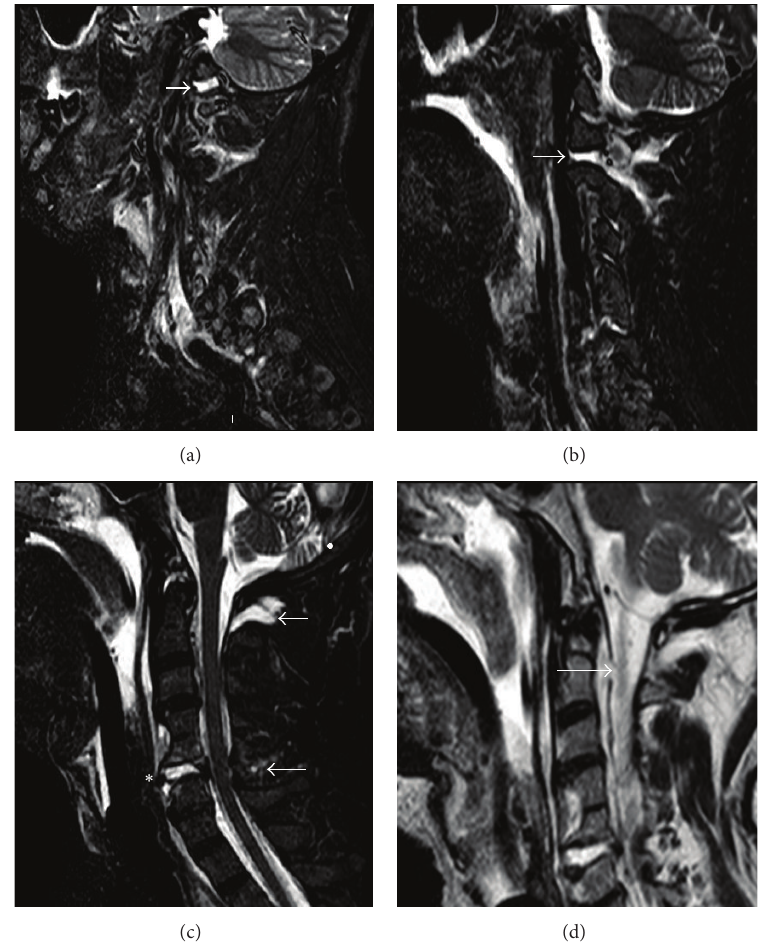
Figure 1: Multiple preoperative sagittal magnetic resonance images (MRI). (a) Left parasagittal short tau inversion recovery (STIR) image demonstrating abnormal fluid in the left atlantooccipital joint (arrow). (b) Left parasagittal STIR image demonstrating abnormal fluid in the left C1-C2 joint (arrow). (c) Midline sagittal STIR image demonstrating disk disruption at the C5-C6 level ( ∗ ) and abnormal signal demonstrating posterior ligamentous injury at the occiput-C1 level (rostral arrow) and at the C5-C6 level (caudal arrow). (d) Sagittal T2- weighted MRI demonstrating ventral dural defect at the level of C2